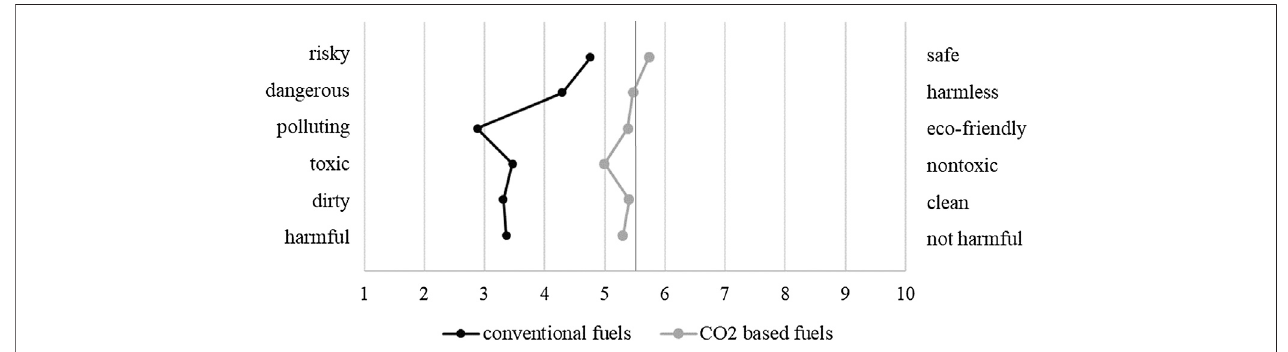
FIGURE 1 | Evaluation of CO 2 -based and conventional fuels in